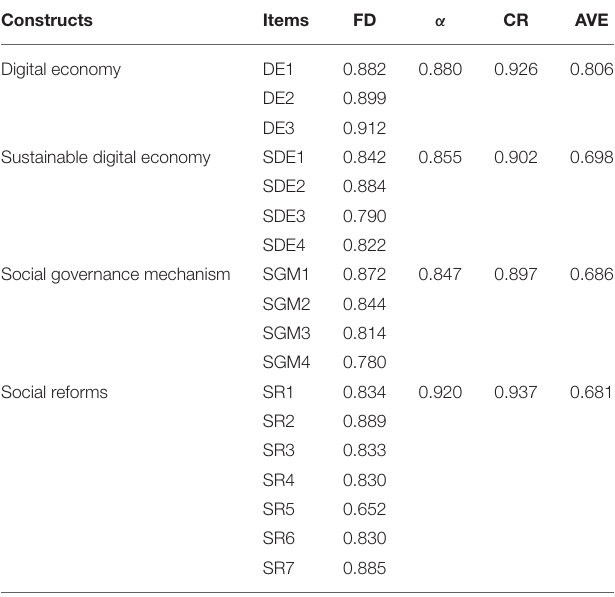
TABLE 2 | Model measurement and descriptive statistics.